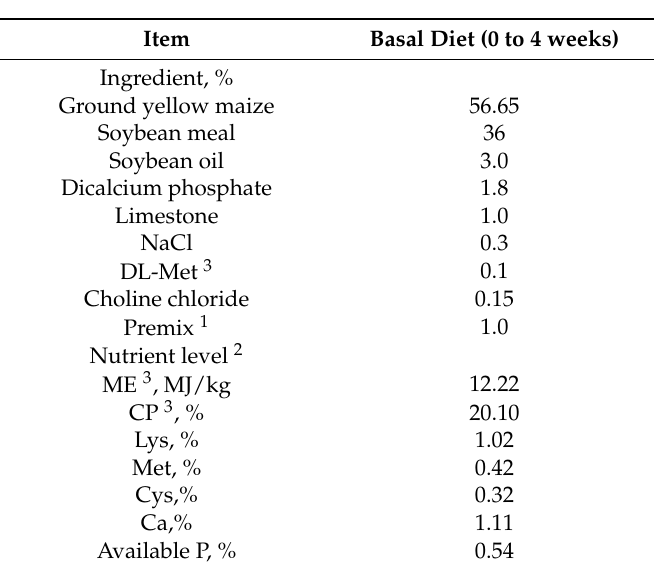
Table 1. Composition of the basal